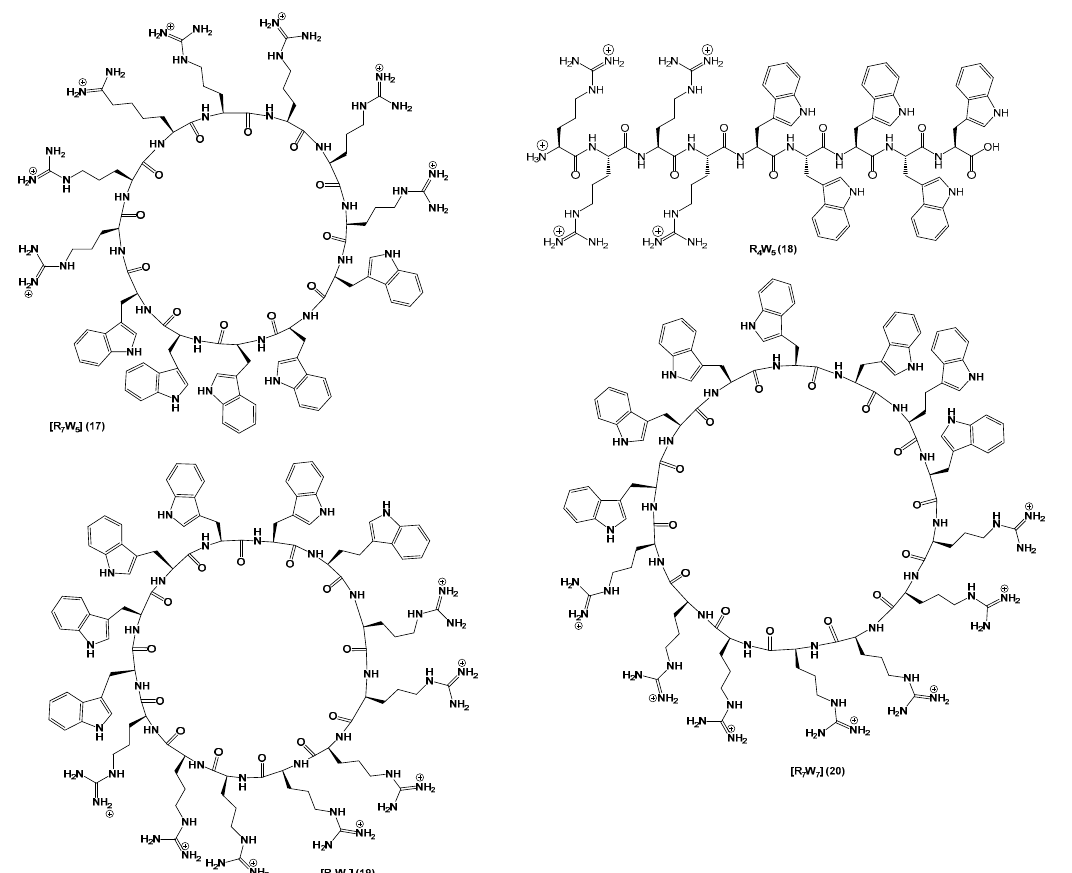
Figure 4. Chemical structures of [R 7 W 5 ], R 4 W 5 , [R 7 W 6 ], and [R 7 W 7 ].